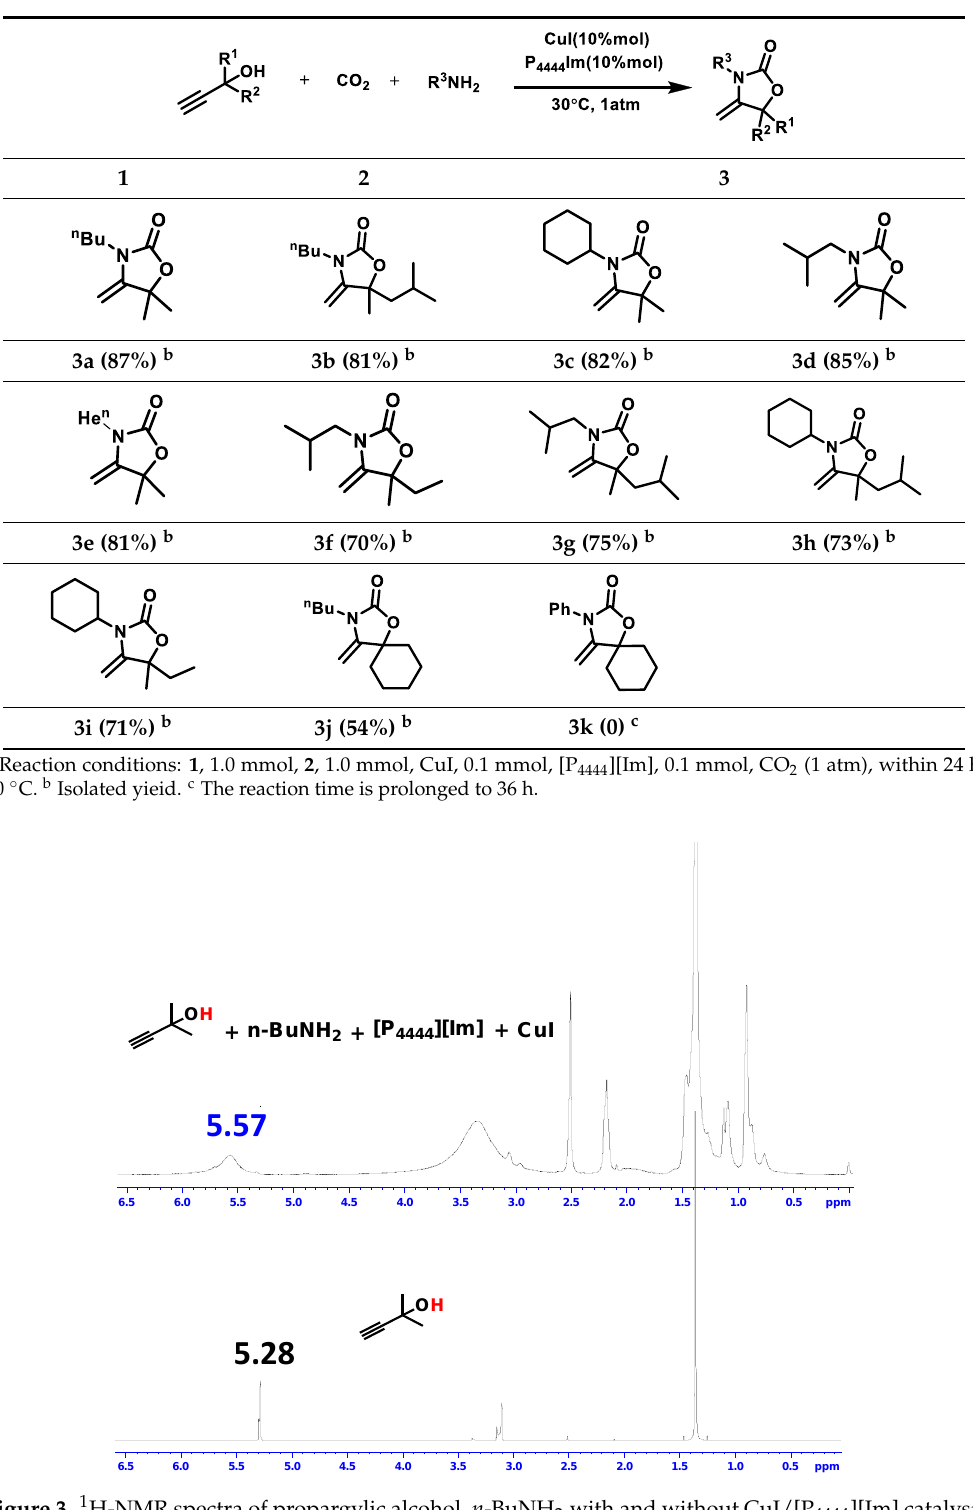
Figure 4. 13 C-NMR spectra of propargylic alcohol, n -BuNH 2 with and without CuI/[P 4444 ][Im] catalyst.